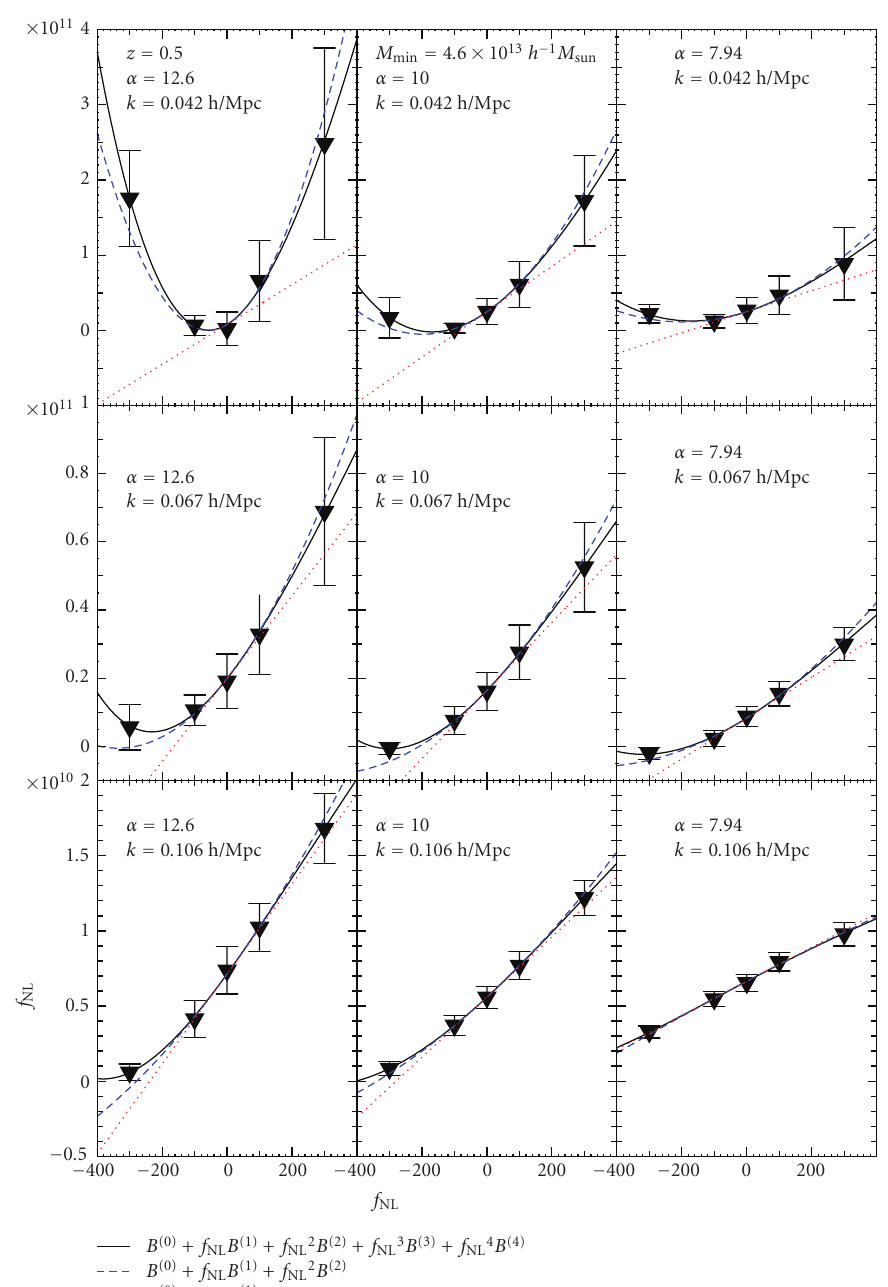
Figure 22: Measurements of a set of triangular configurations of the halo bispectrum in N-body simulations with local non-Gaussian initial conditions, as a function of the non-Gaussian parameter f NL . Large values of the parameter α correspond to more squeezed configurations. is evident, from the study by Nishimichi et al. in [213]. In the upper panels, the dependence of the halo bispectrum on f 2 NL